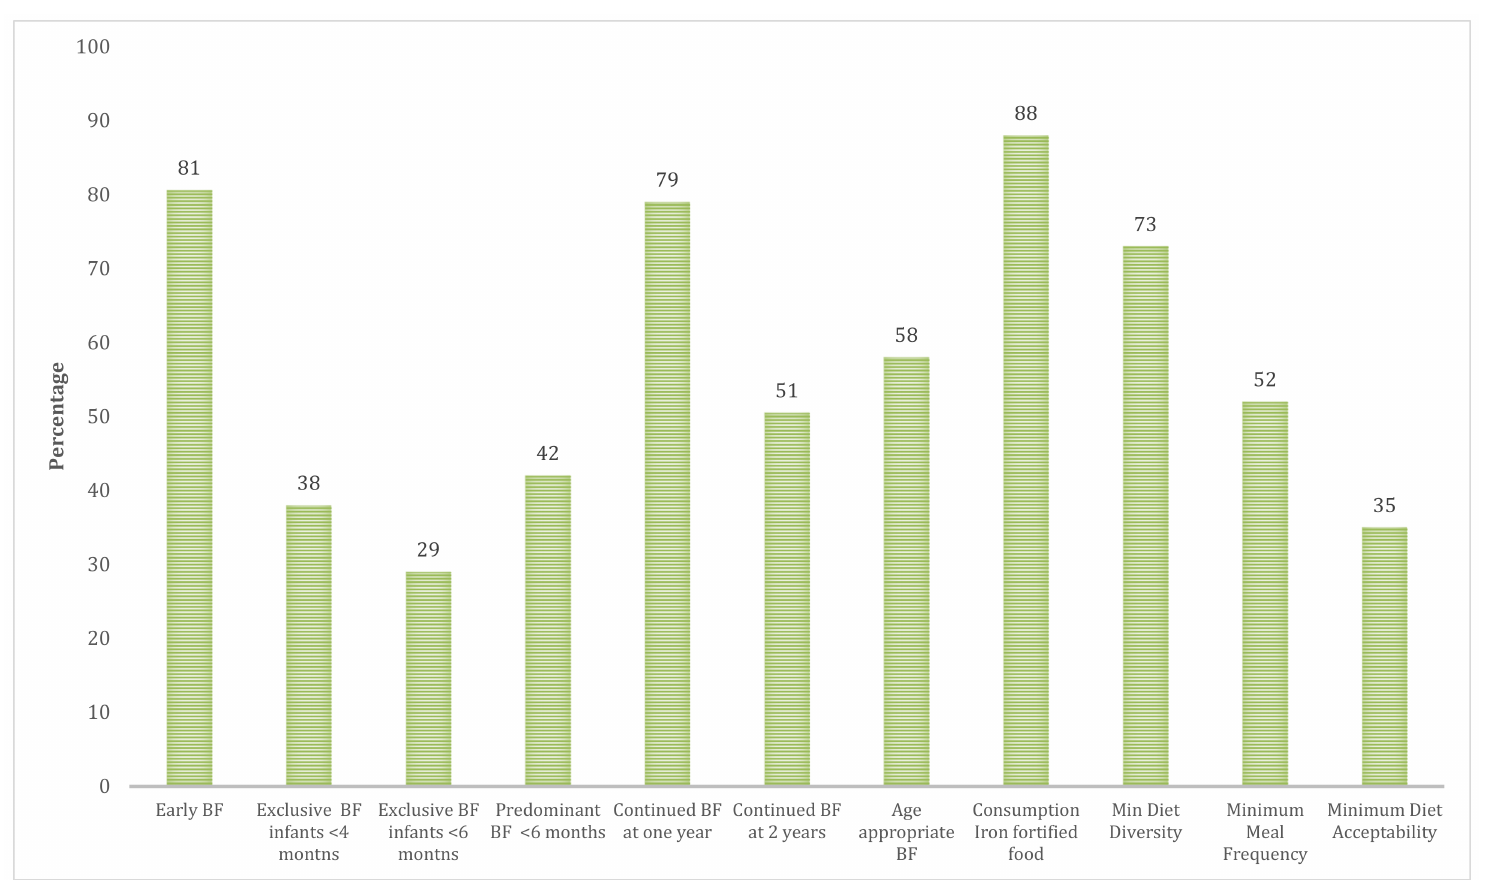
Figure 1. Children feeding indicators. BF: